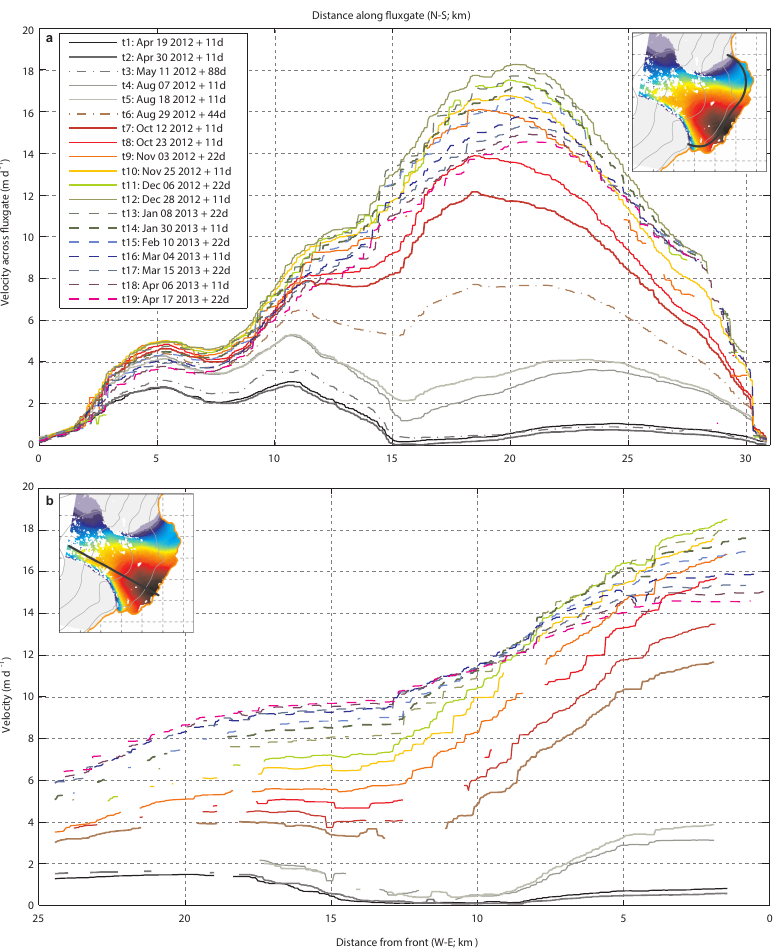
Figure A1. Evolution of ice-flow velocities across a calving fluxgate (a) and along a central flowline of Basin-3 (b) . Velocity profiles extracted from TerraSAR-X velocity maps April 2012 to May 2013 and median filtered to remove outliers. The insert shows the location of the profiles overlain onto the velocity map of t 14 . Fluxgate velocities are used to compute the calving ice flux. Velocities for long repeat passes t 3 and t 6 have been constructed as described in B2.